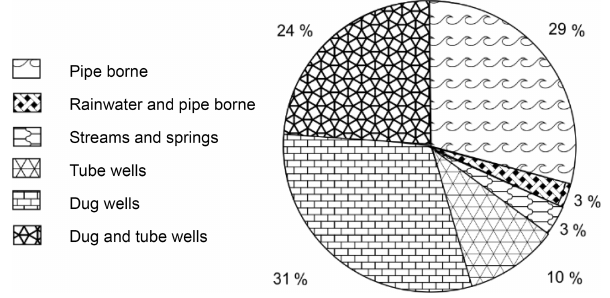
Figure 4. Water sources used by the total